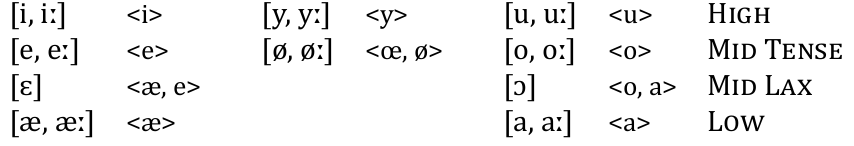
Table 3: Old Norwegian sound–letter